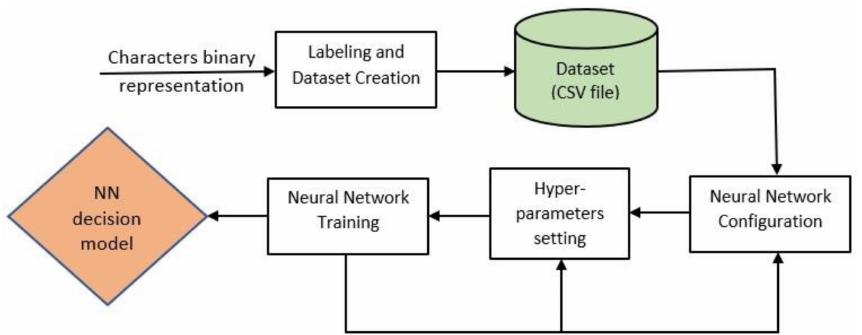
Figure 7. Neural network design and training